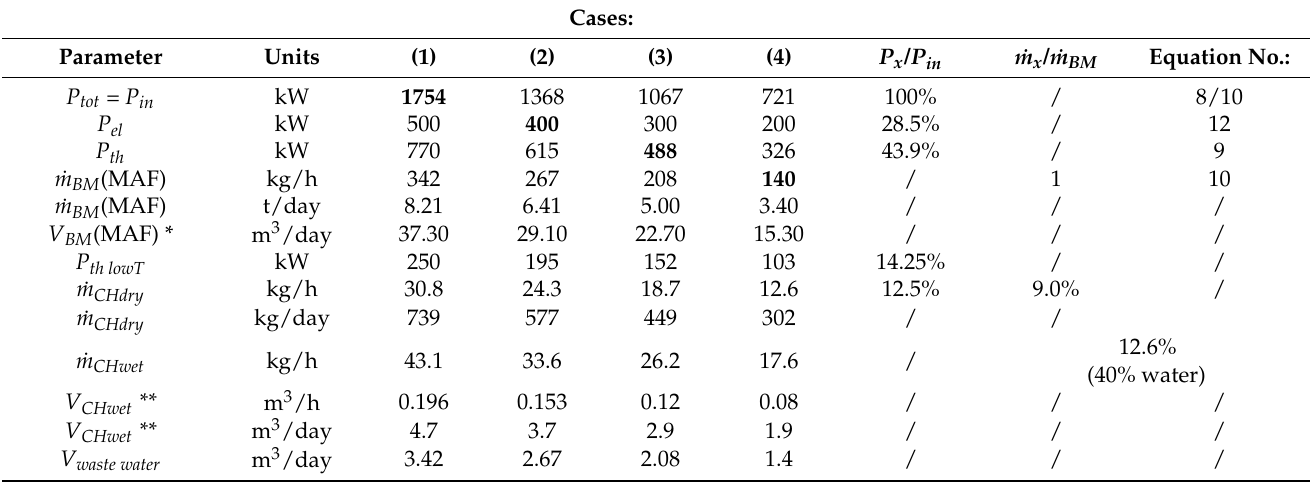
Table 4. Summary of the results of mass and heat balance of four plant capacity definition.